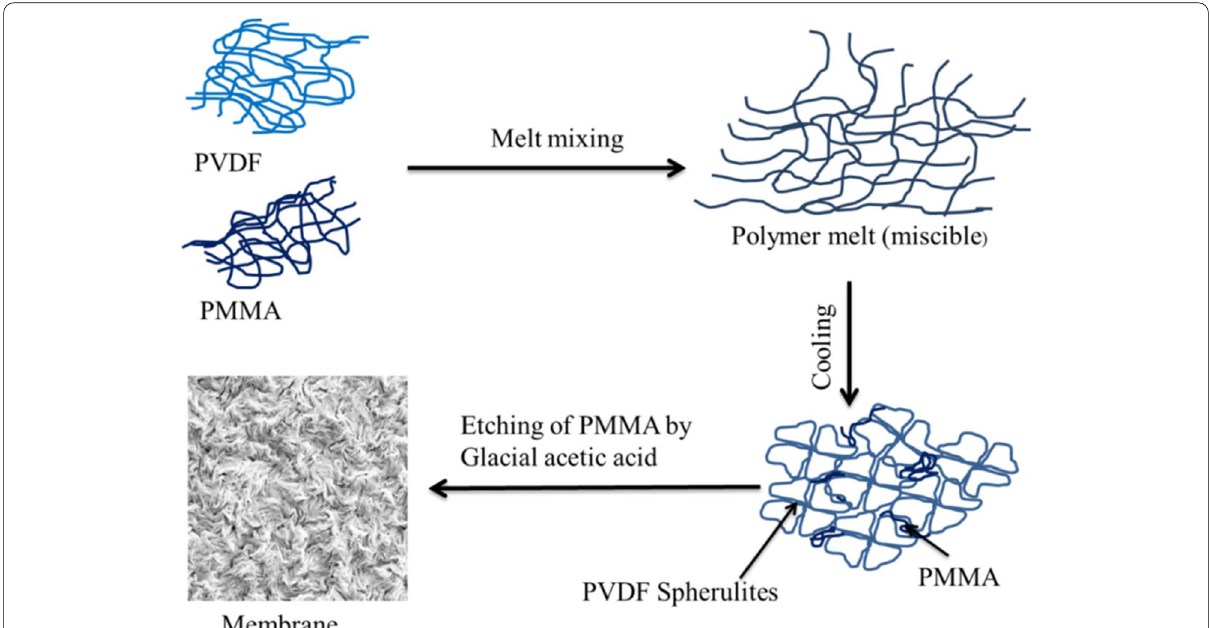
Fig. 1 A cartoon illustrating schematically as to how the the membranes were fabricated by etching out the PMMA phase from the crystallization driven phase separated